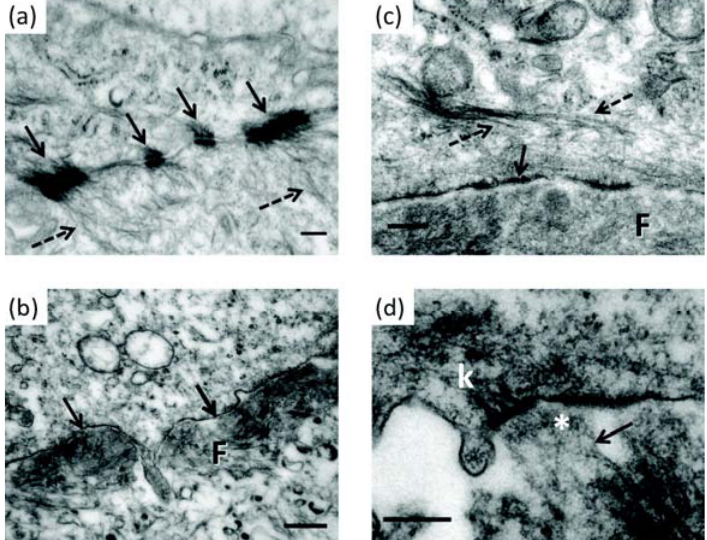
FIGURE 6 - Electron micrographs of the cultived ephitelium. ( a ). Portions of two adjacent cells of the stratum basale . The junctional surface of neighboring cells shows typical desmosomes ( arrows ) with its characteristic electron-dense cytoplasmatic plaques, laying either side of the contacting membranes of the keratinocytes. Observe that the intermediate filaments ( dotted arrow ) converge upon the desmosomes. ( b ). A region of epithelium cell-substrate association. Note the high concentration of fibrin fibers ( F ) underlaying the basal surface of the cell. Arrows point to the cell membrane. ( c ). Intermediate filaments ( dotted arrows ) converge upon hemidesmosomes-like structures ( arrow ) at the cell basal surface just above the fibrin substrate ( F ). ( d ). High power electron micrograph of the basal surface of a cell from the basal layer of the epithelium, illustrating a hemidesmosome consisting of a dense cytoplasmic plaque, the site of keratin bundle ( k ) attachment, a sub-basal dense plate, and anchoring filaments that project extracellularly and appear to insert into the basal lamina region ( asterisk ). Anchoring fibrils occur in the substrate beneath hemidesmosomes ( arrow ). Bars: (a, c and d) 0.2µm; (b)